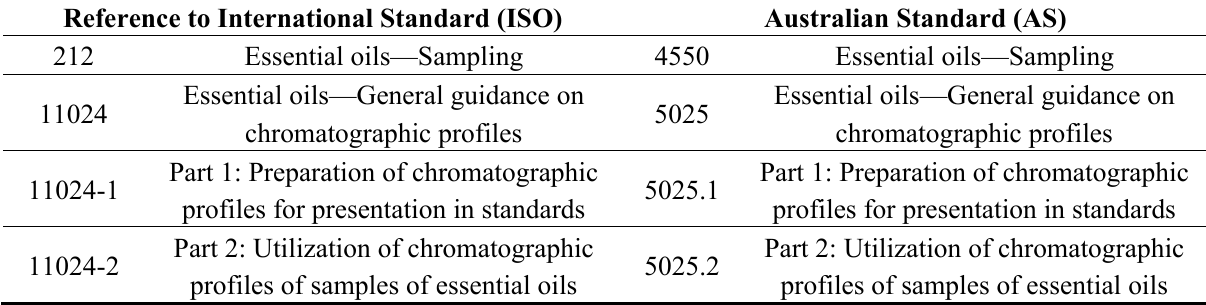
Table 1. References equivalent between the International Standards Organisation (ISO) and Australian Standards (AS) in relation to essential oils and preparation of standards for